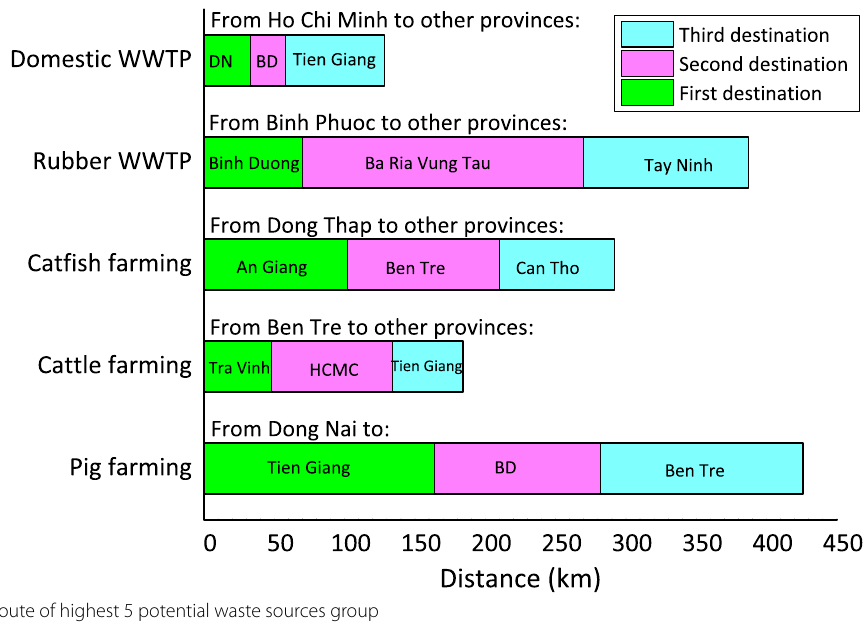
Fig. 5 Collection route of highest 5 potential waste sources group